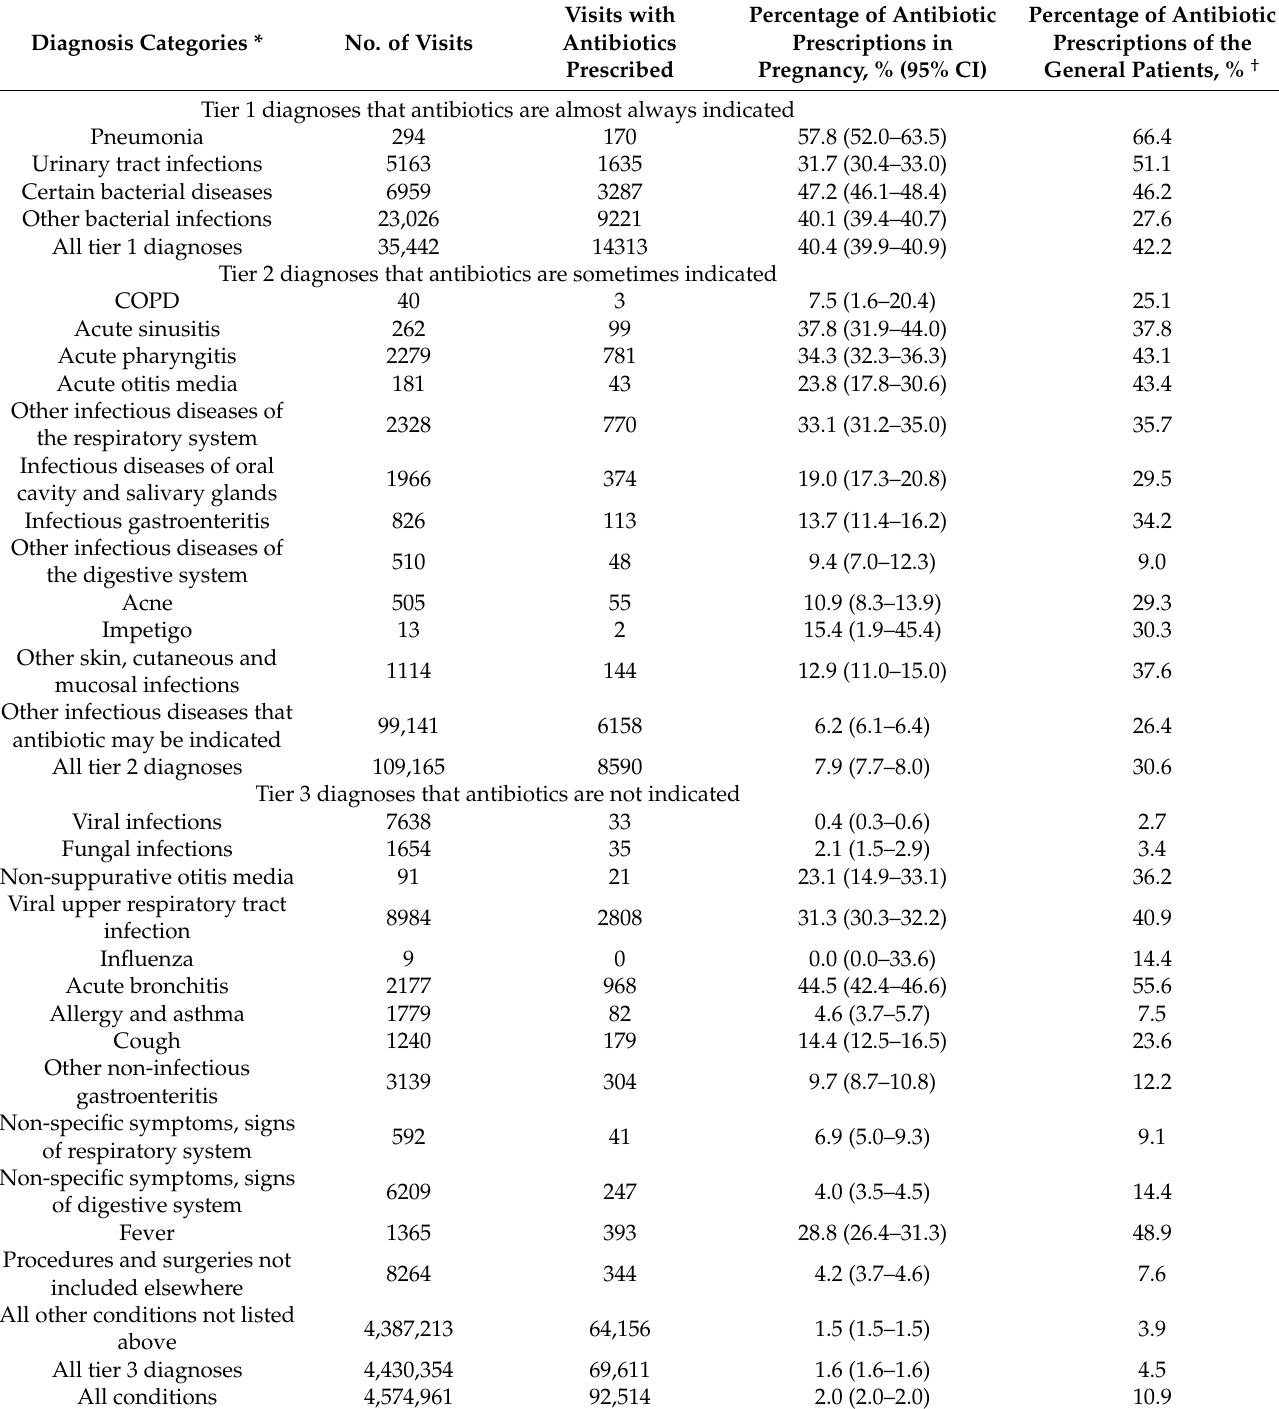
Table 3. Percentages of antibiotic prescriptions for various diagnosis